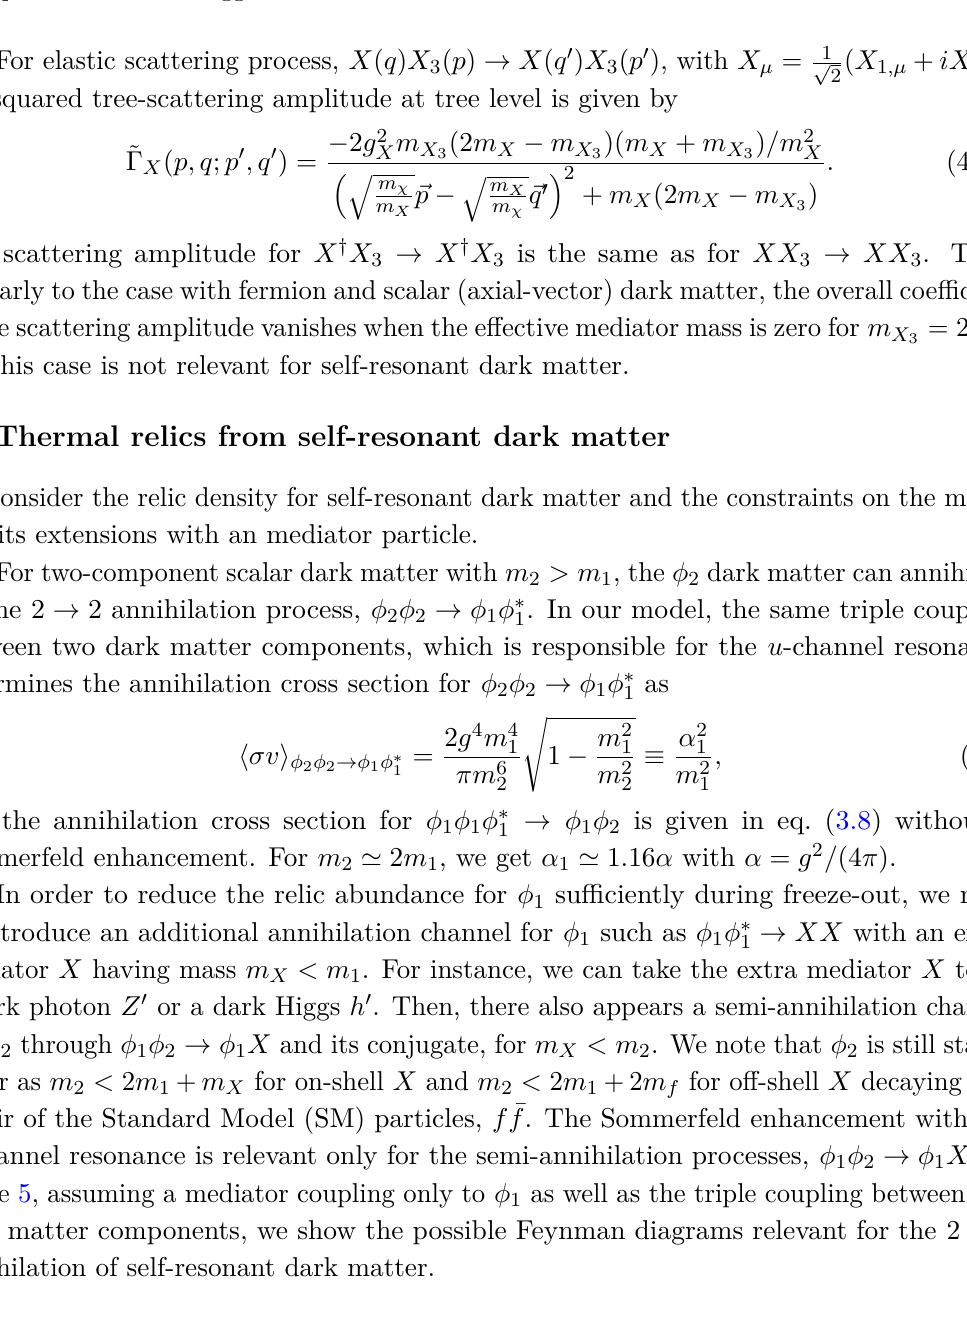
Figure 5 . Feynman diagrams for the annihilation of self-resonant dark matter. Here, X can be a dark photon or a dark